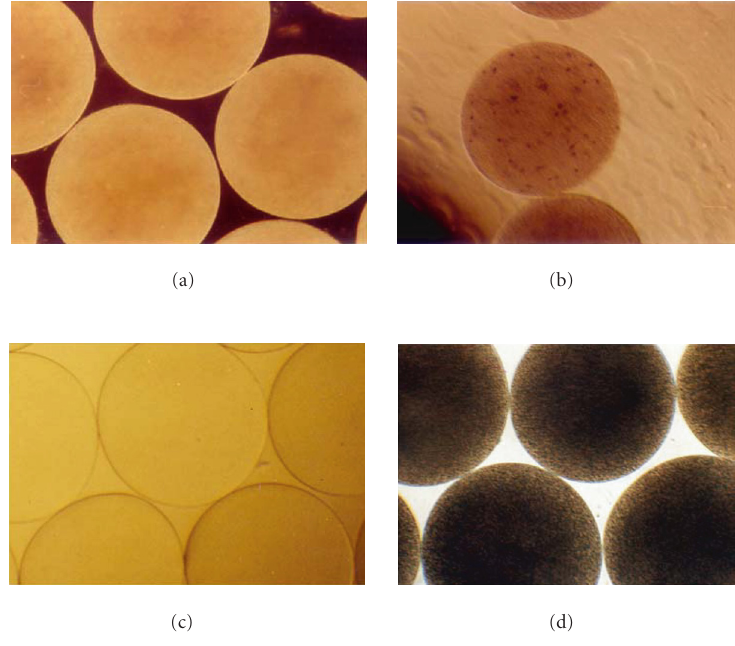
Figure 2. Artificial cells for bacterial cell therapy in kidney failure, elevated blood cholesterol, and other diseases. (a) Empty APA artificial cells. (b) APA membrane artificial cells with visible engineered E coli DH5 cells; with permission from Chang and Prakash [72]. (c) Empty APA artificial cells. (d) APA membrane artificial cells with thousands of engineered L plantarum 80 (pCBH1) cells; with permission from Jones et al